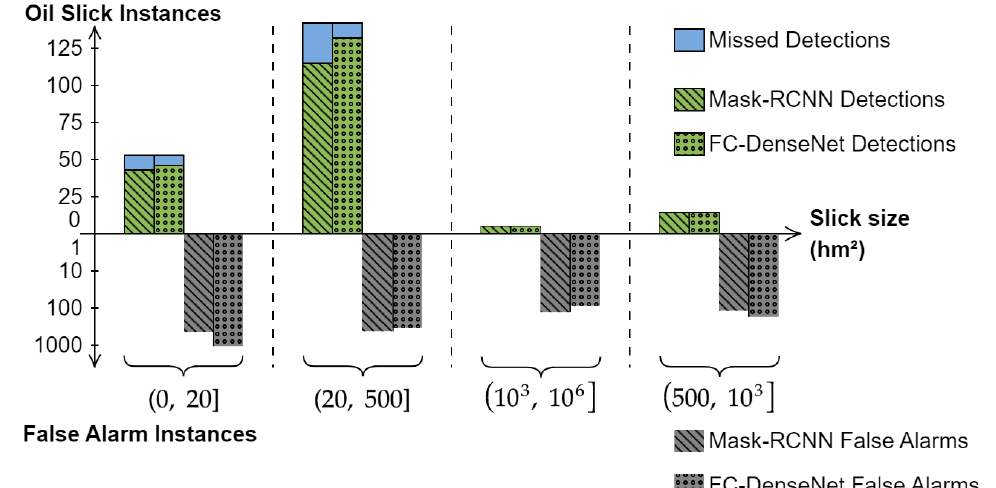
Figure 15. Detection performance of FC-DenseNet and Mask R-CNN as a function of ground truth size (hm²), same legend as Figure 14.